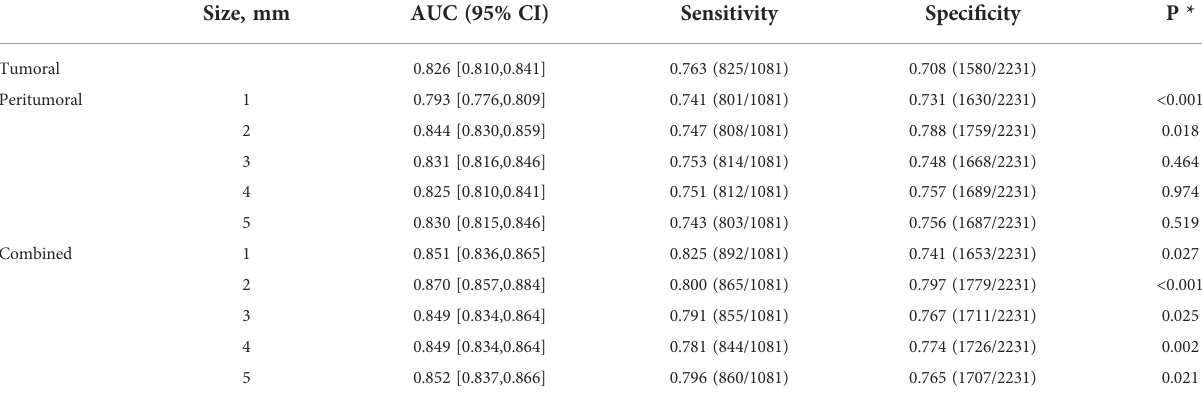
TABLE 5 Benign/malignant classi fi cation performance of deep learning models in ROI